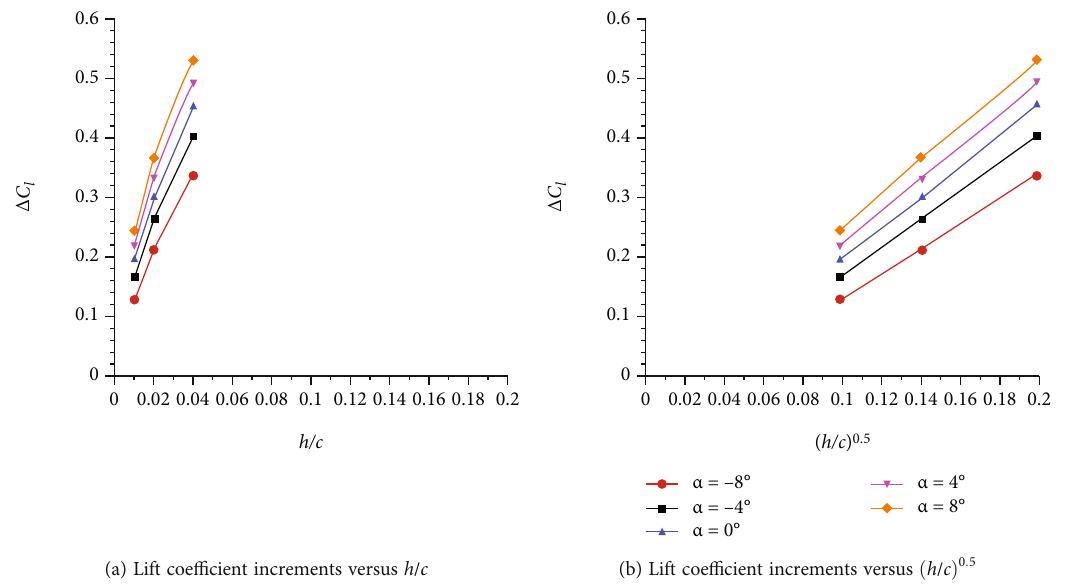
Figure 11: Variation of lift coe ffi cient increment with GF relative